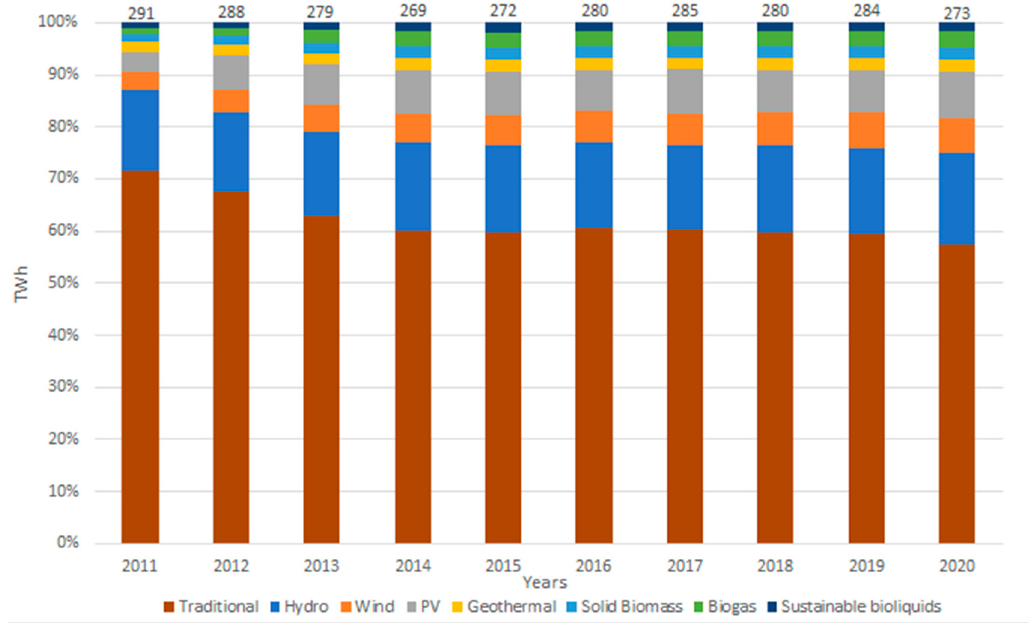
Figure 4. Evolution of the net Italian production by color. The top of the columns shows the yearly energy production values in TWh.